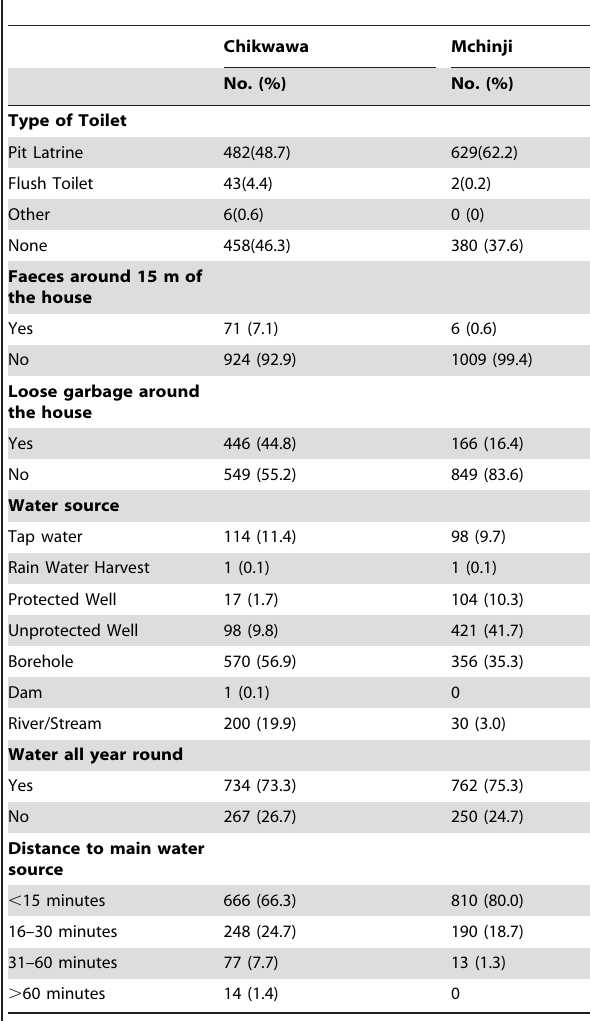
Table 2. Availability of household characteristics in Chikwawa and Mchinji districts.